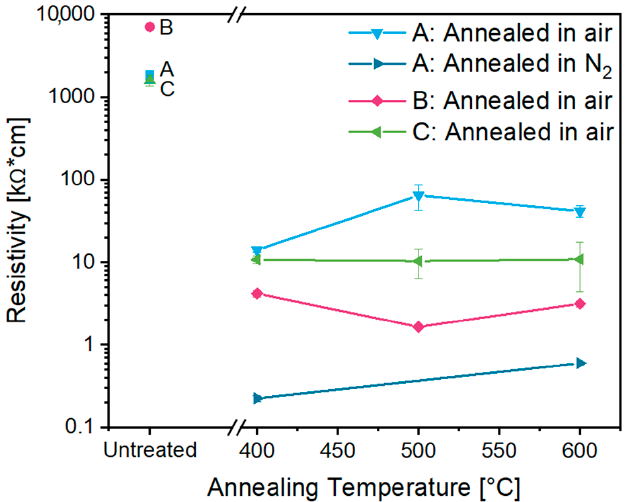
Figure 13. Electrical resistivity as a function of ITO aerogels A (blue square), B (rose circle) and C (green diamond) after CPD and after annealing in air and N 2 at temperatures in the range of 400–600 °C.